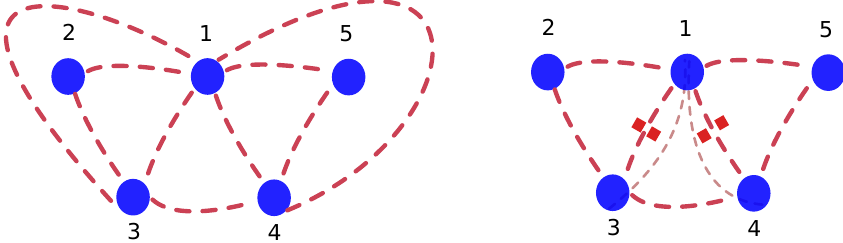
Figure 2 . We consider the tessellation of a (cid:12)ve-point function involving (cid:12)ve protected operators (blue dots). Left: we tessellate the (cid:12)gure by mirror cuts (dashed lines), which can be further decorated by inserting pairs of mirror magnons. Right: the object of our interest is when two pairs of virtual particles (red boxes) sit on edges 13 and 14 in this case, the hexagon 143 contains two mirror particles, which gives rise to a non-trivial mirror-mirror scattering. Note that the mirror particles are arbitrary bound-states and have arbitrary momenta. As we will often do, we represented the outermost cuts \behind" the (cid:12)gure (using lighter